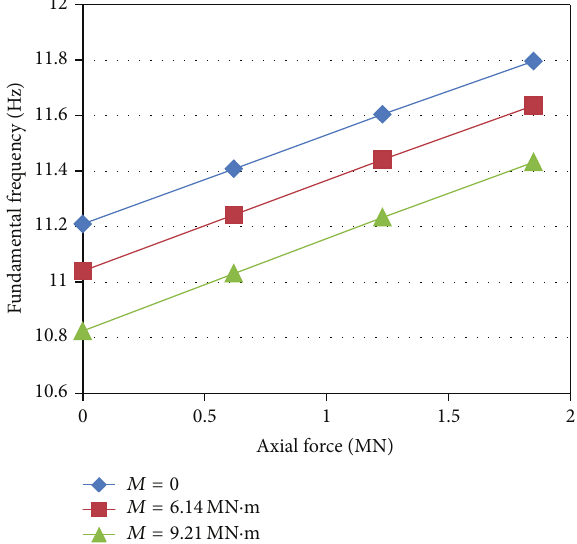
Figure 5: Variation of the fundamental frequency with tensile force and end moment; clamped-clamped (C-C) boundary condition.